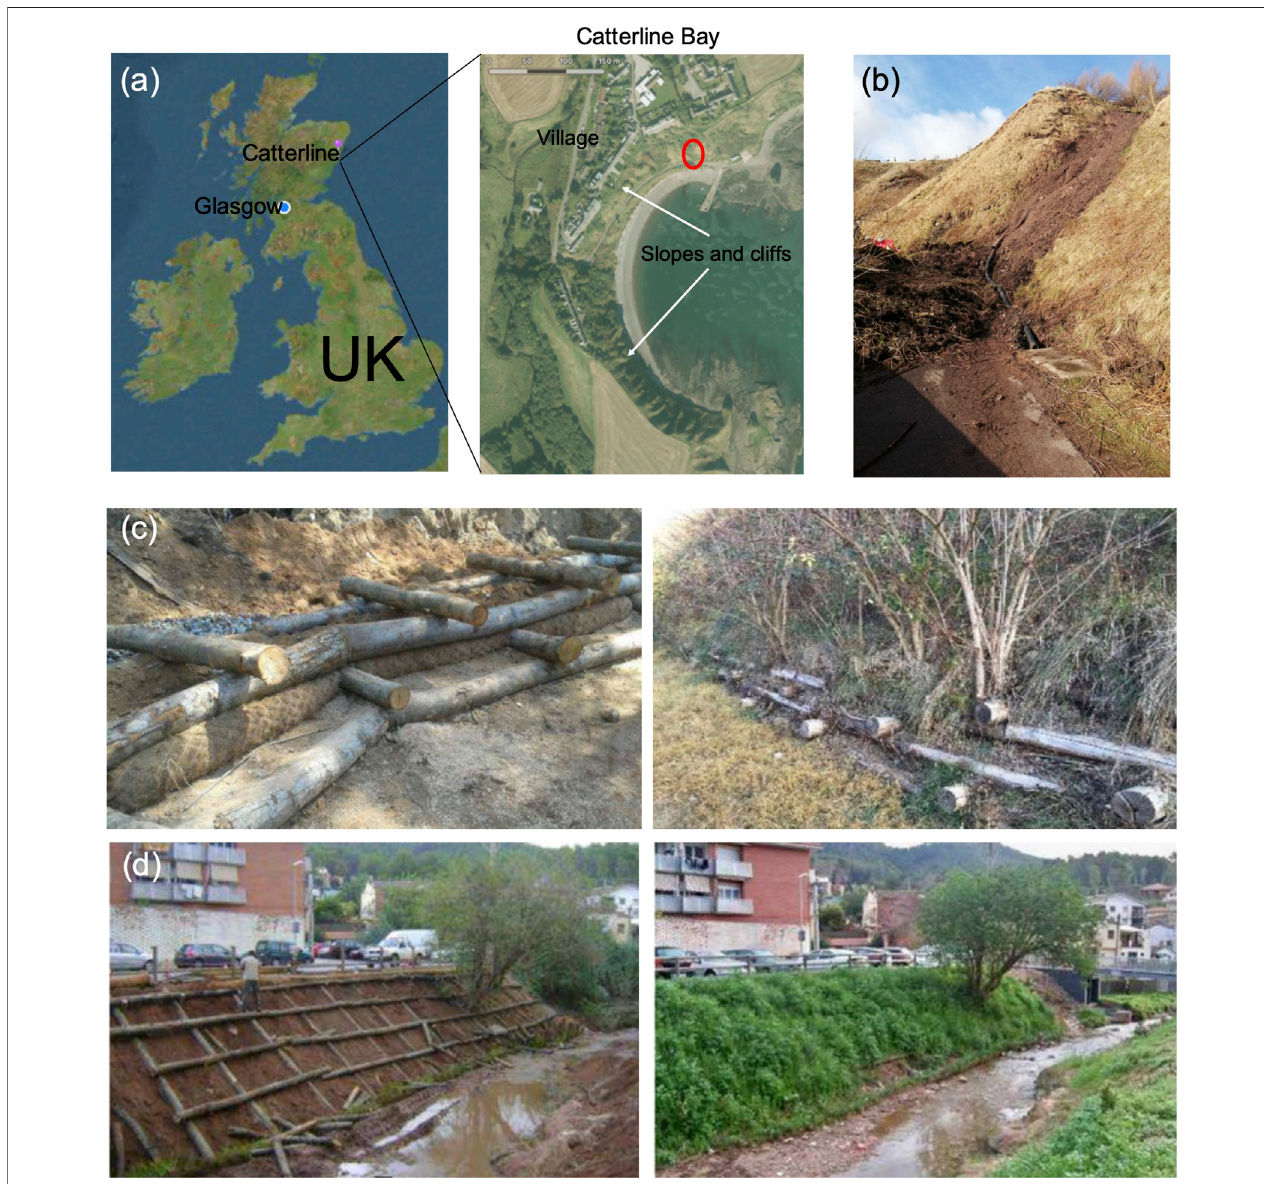
FIGURE 1| (A) The OAL-UK is located in Catterline bay, in NorthEast Scotland, where (B) frequent landslide and erosion events are triggered by heavy rainfalland surface water accumulation, putting at risk properties and infrastructure in the village of Catterline; (C) left: live cribwall under construction and (right) after a dense vegetation cover has been established on the cribwall; (D) Left: vegetated slope grating under construction and (right) after the vegetation cover has started to get established on the NBS action. Credit photos: Albert Sorolla Edo – Naturalea.